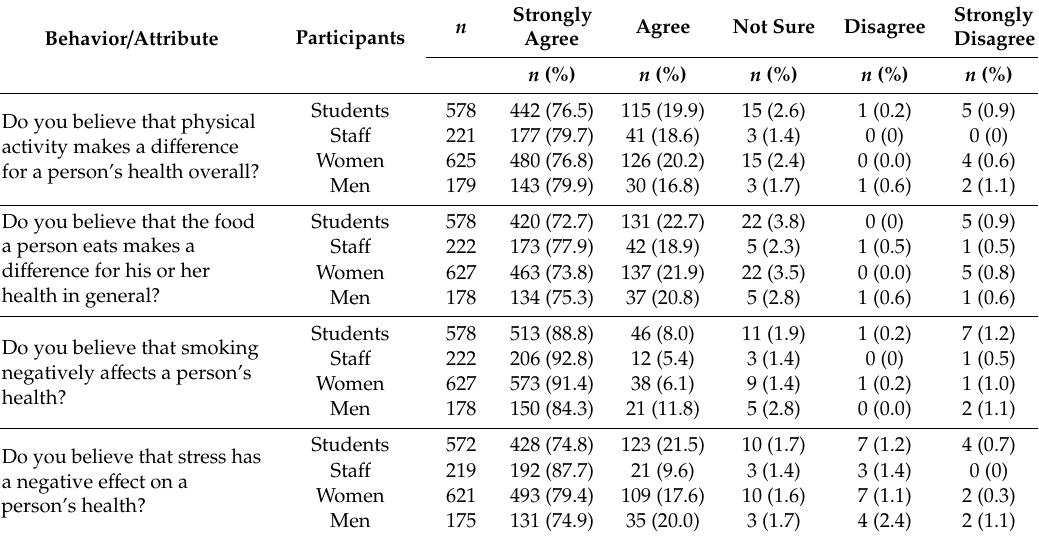
Table 4. Participants beliefs about the relationship between four lifestyle-related behaviors / attributes and general